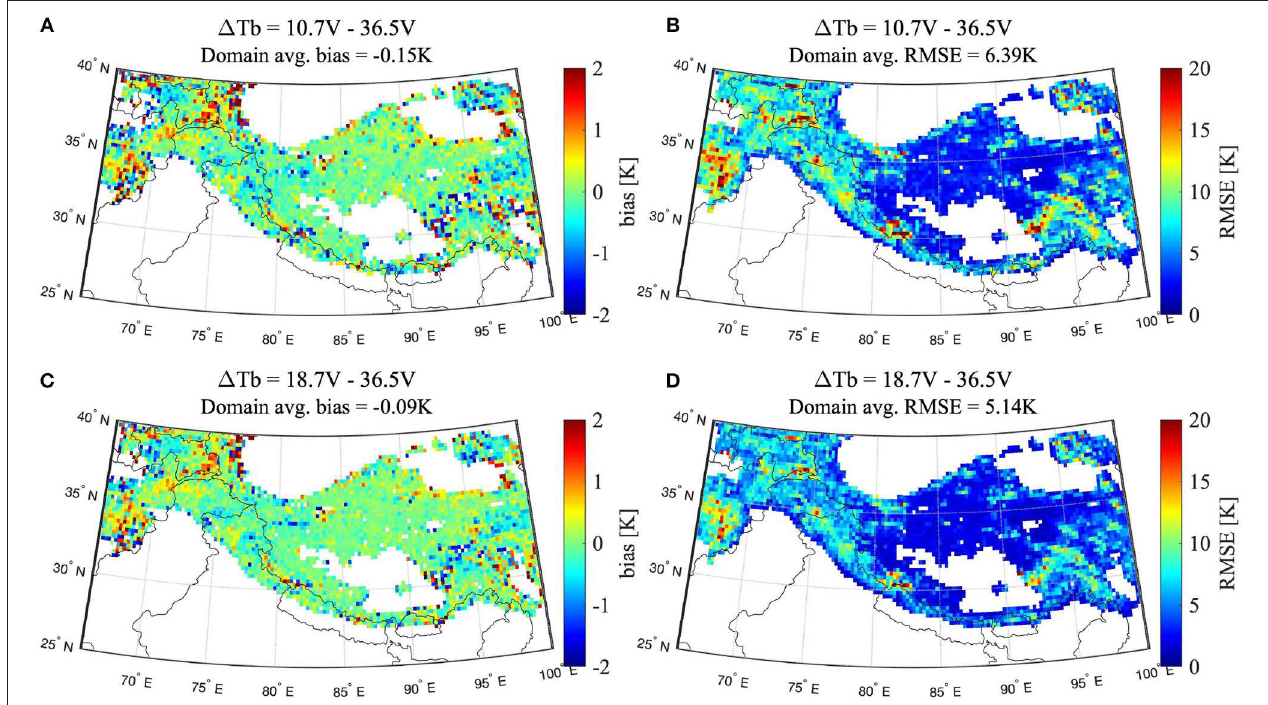
FIGURE 3 | Average bias and RMSE for SVM-based 1 Tb predictions vs. AMSR-E observations (2002–2011) across snow-covered areas in HMA. Black lines represent country demarcations while the white regions represent areas with limited (or no) snow coverage during the study